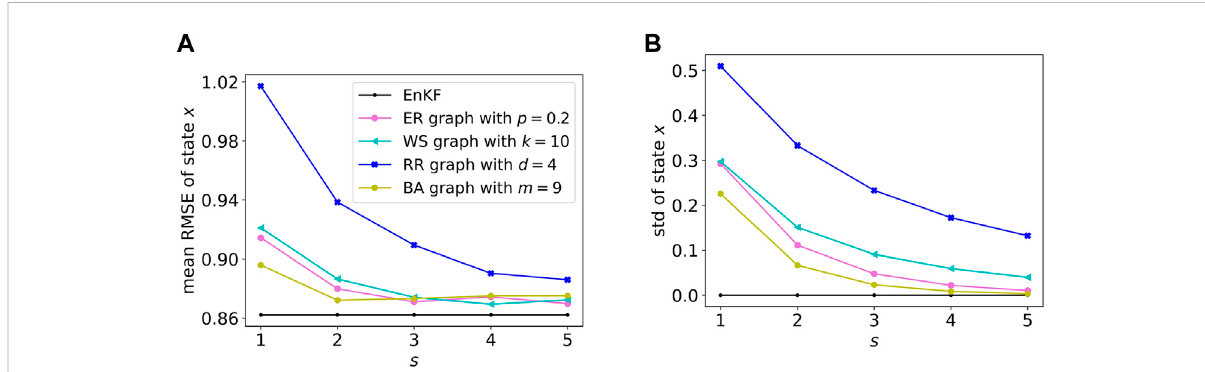
FIGURE 2 Meanandstandarddeviationofallparticleswithdifferentcommunicationrounds s . (A) ShowstheMeanRMSEofparticlesand (B) istheplotthe mean of { std k , k = 1, 2, ... , K } to display the homogeneity performance.